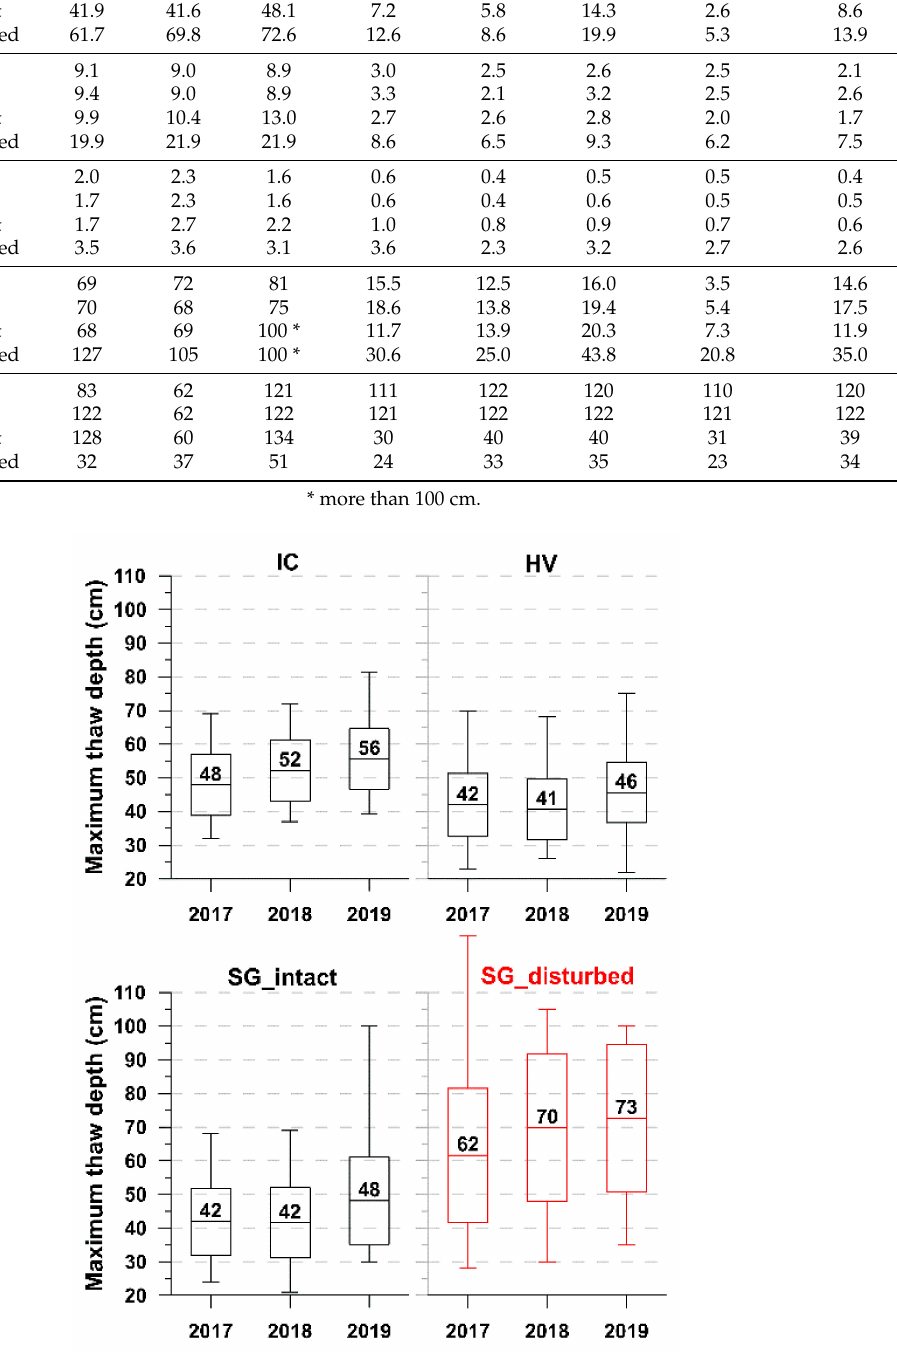
Figure 4. Box–whisker plot of changes and differences in thaw depth at the end of thawing periods at sites IC, HV, and SG in years 2017–2019. For SG, statistics are shown separately for survey points in the intact tundra area (SG_intact) and the disturbed area in red color (SG_disturbed). The box limits are standard deviations. Mean values are indicated as lines in the boxes and labeled. The whiskers indicate minimum and maximum